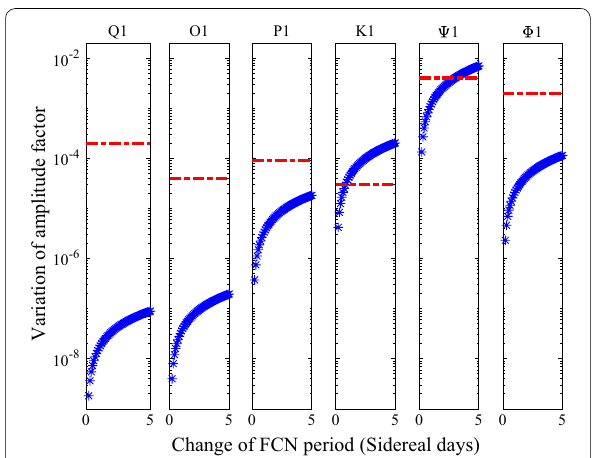
Fig. 2 Relationship between the variations in amplitude factor and the FCN period. The horizontal axis represents the change of FCN period. The vertical axis is the corresponding variation in amplitude factors for 6 diurnal waves. The dash dotted line represents the high precision level of tidal parameters from the current global SG observations